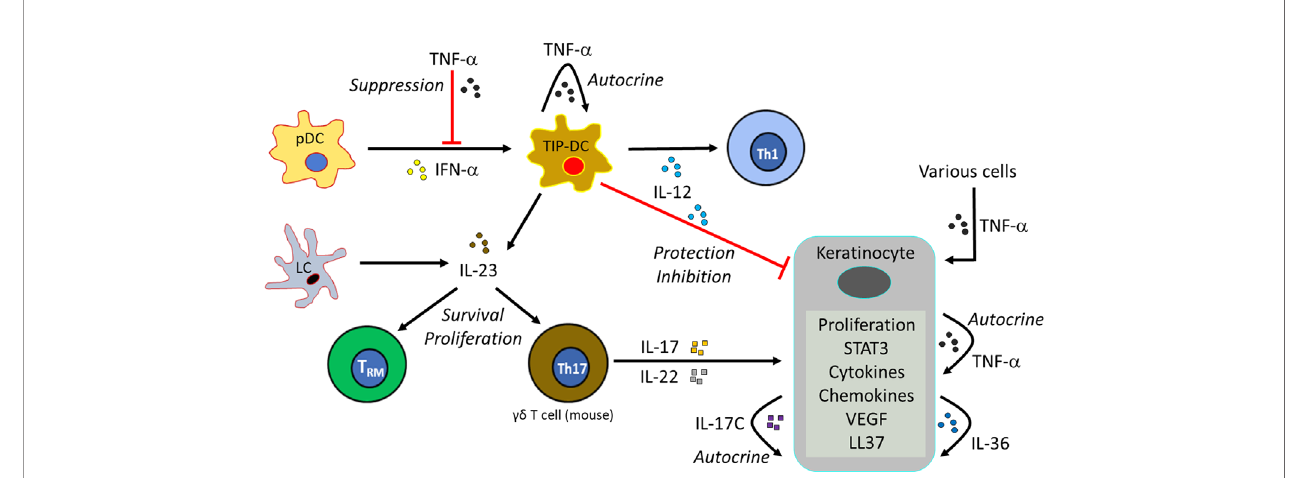
FIGURE 5 | Mechanism of